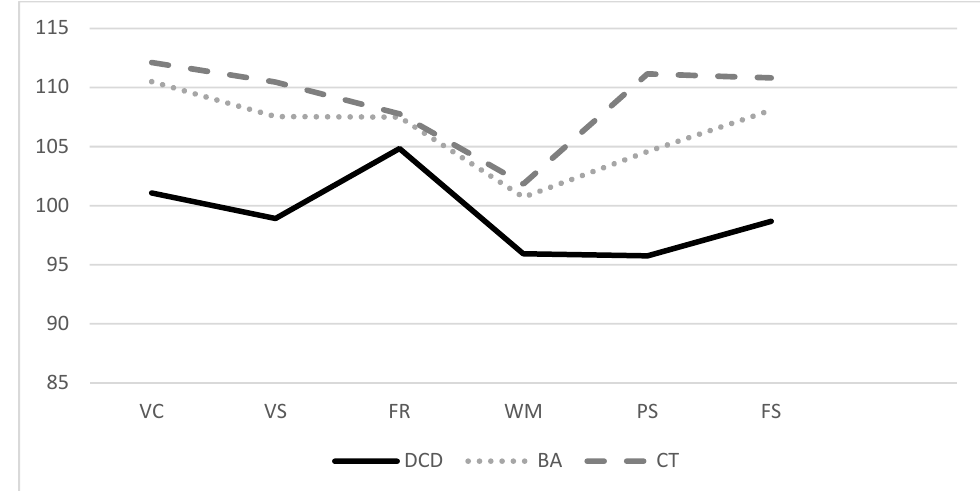
Figure 1. Mean scores of the primary WIPPSI-IV index scores and the FSIQ as comparison between groups. Note: VC = Verbal Comprehension, VS = Visual Spatial, FR = Fluid Reasoning, WM = Working Memory, PS = Processing Speed, FS = Full Scale-IQ. Table 3. Descriptive statistics and characteristic values of the one-factor ANOVA for the WPPSI-IV (IQ) subtests (scaled